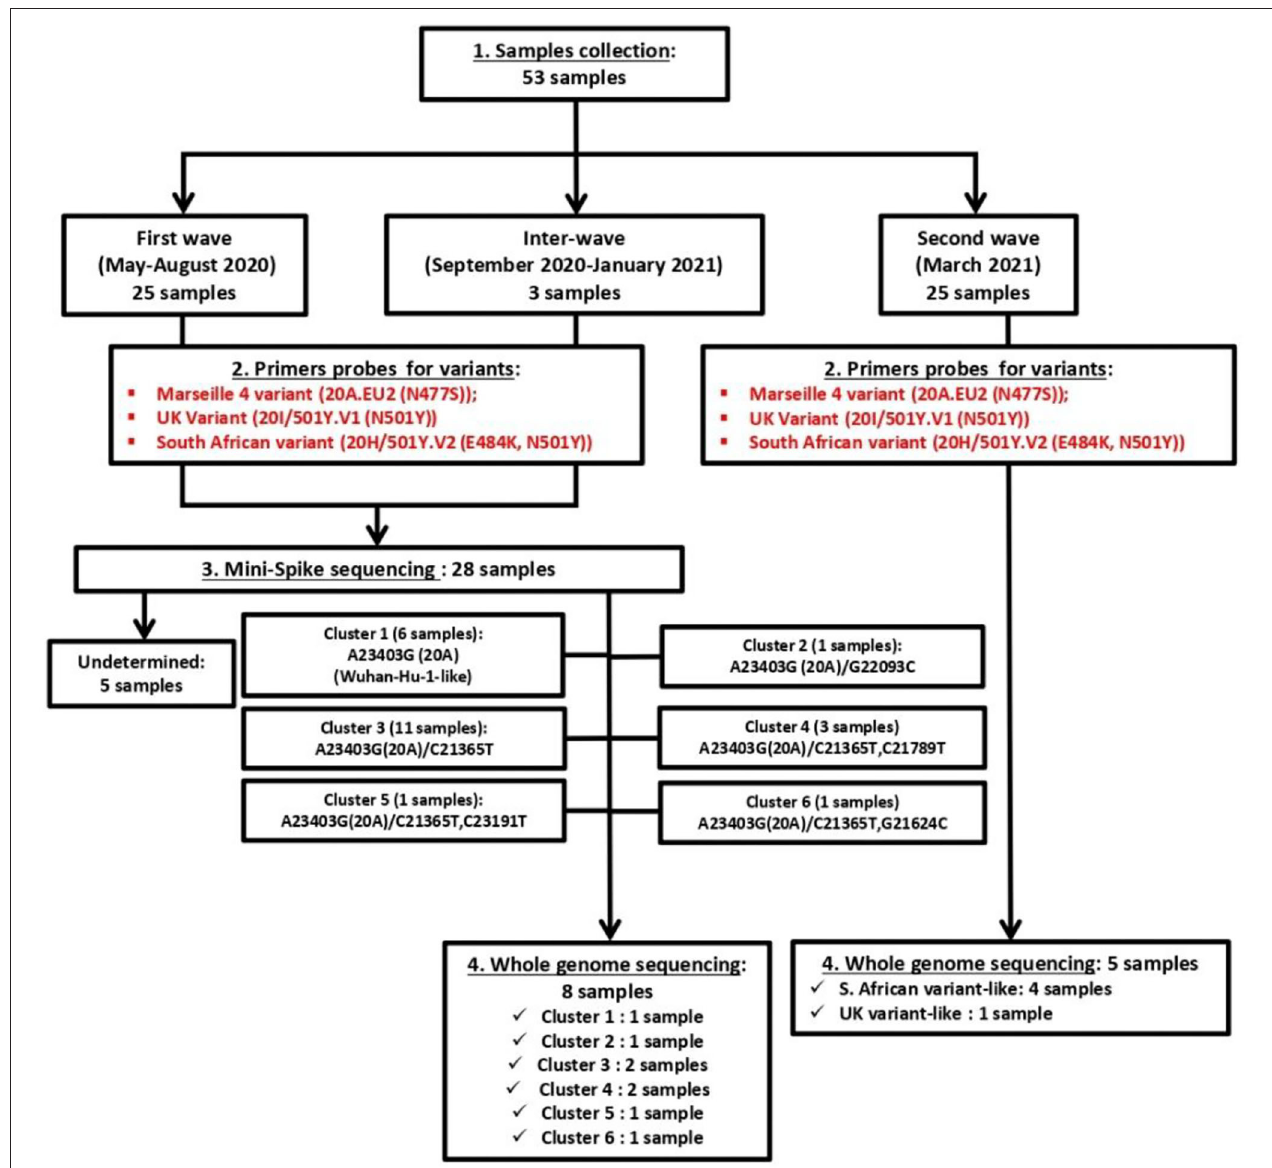
FIGURE 3 | Chart of management of the fifty-three SARS-CoV-2 samples for typing and whole genome